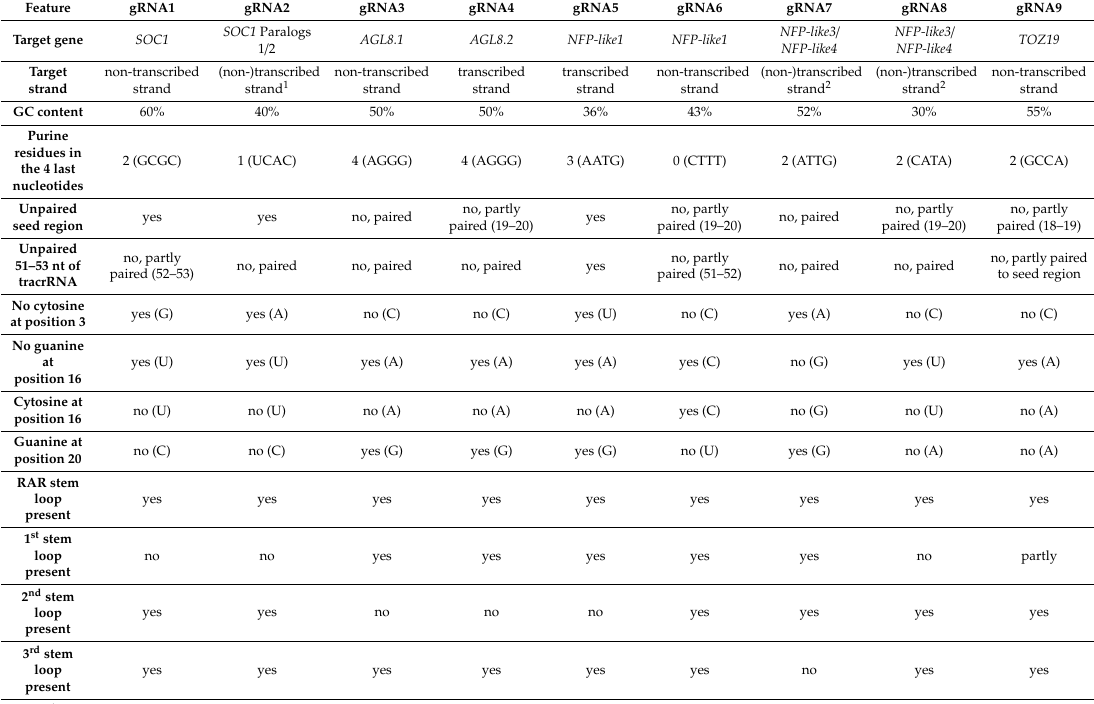
Table 2. Selected features with a possible influence on the e ffi ciency of the applied gRNAs.